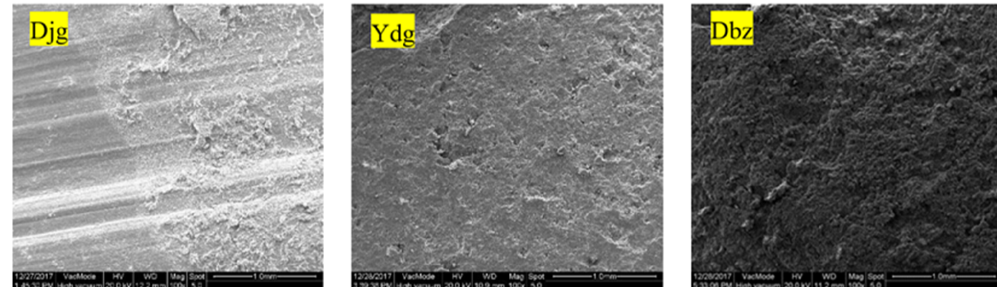
Figure 7. Scanning electron microscope (SEM) photographs of the shear surface of loess samples (100 magnification).